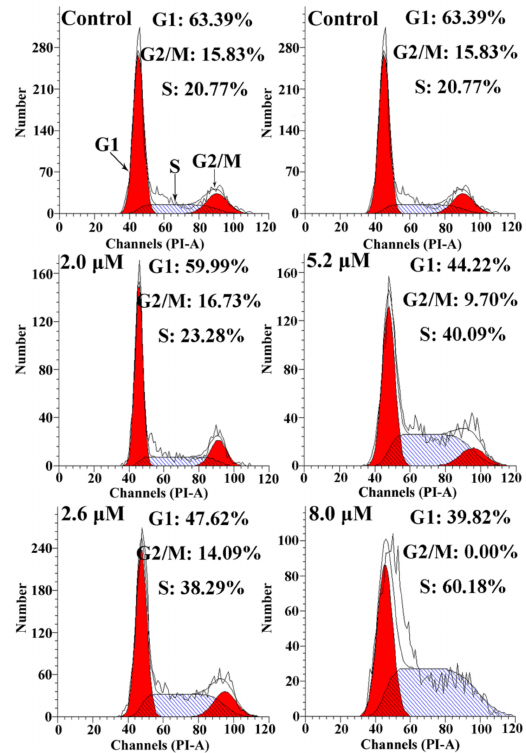
Figure 3. The cell cycle analysis by flow cytometry of MGC80-3 cells treated with complex 1 (2.0, 2.6, 5.2, and 8.0 µ M) for 24 h.